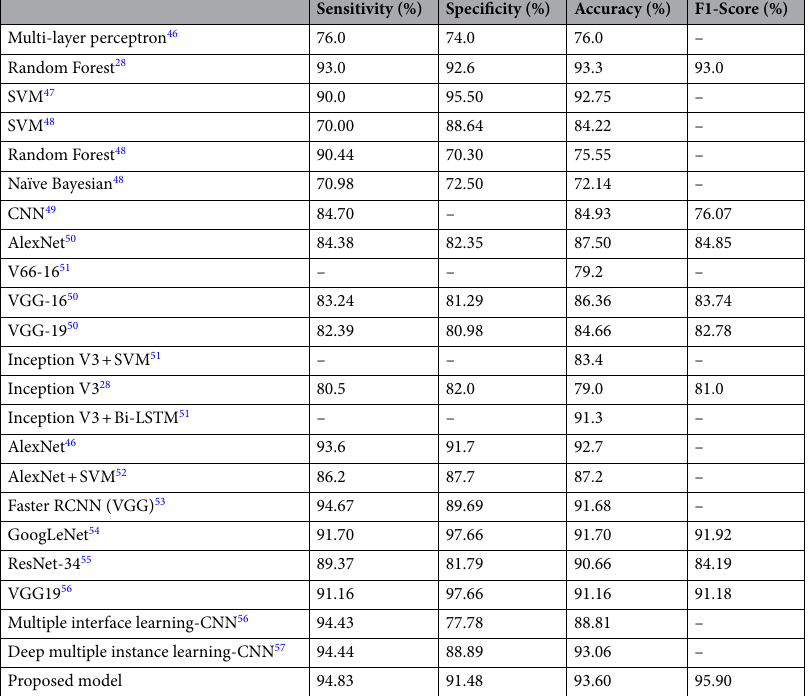
Table 6. Statistical analysis of various state-of-art